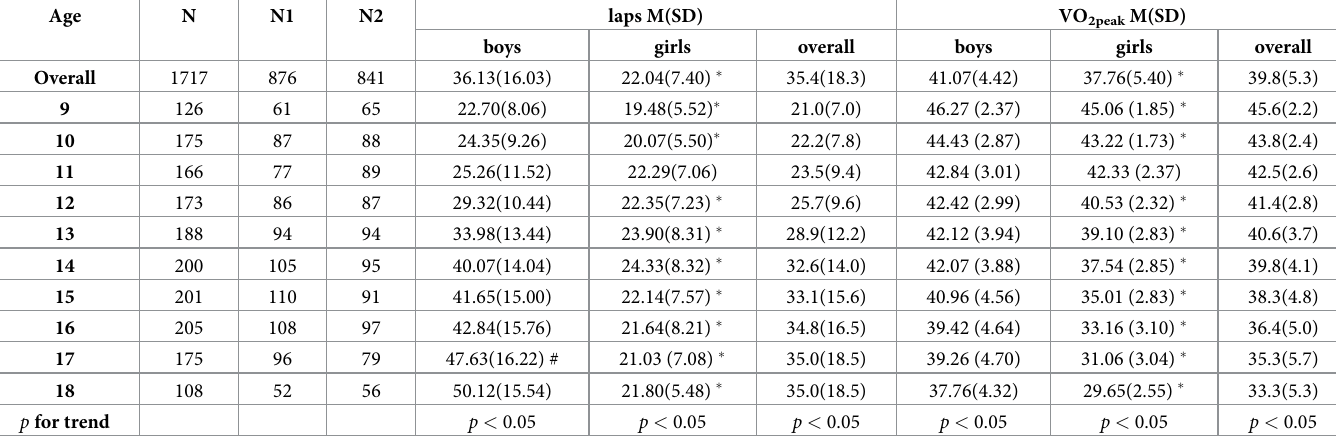
Table 2. 20m shuttle run test (20mSRT) performance (number of laps) and predicted VO 2peak (mL/kg/min) of boys and girls aged 9–18 years in